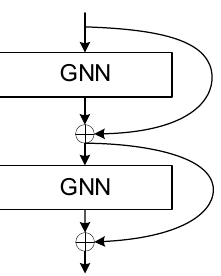
Figure 7. Layered architecture.